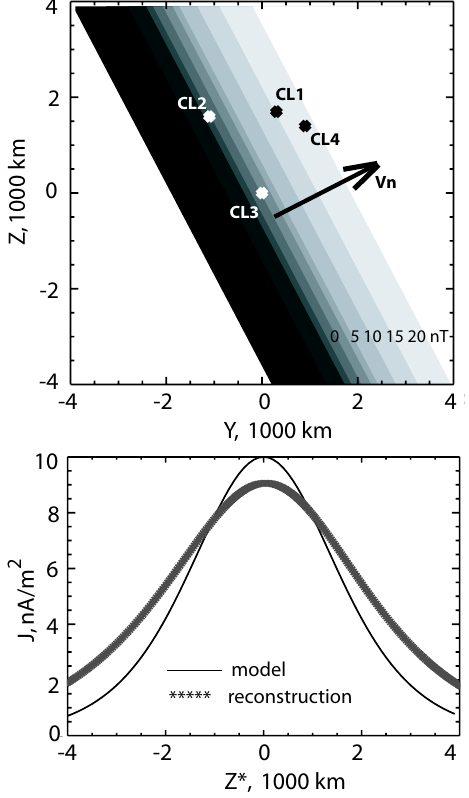
Fig. A1. Upper panel: Model of flapping motion of 1-D current sheet, magnetic field intensity is gray-scale coded. Bottom panel: Model (solid line) and reconstructed (asterisks) profiles of current density.